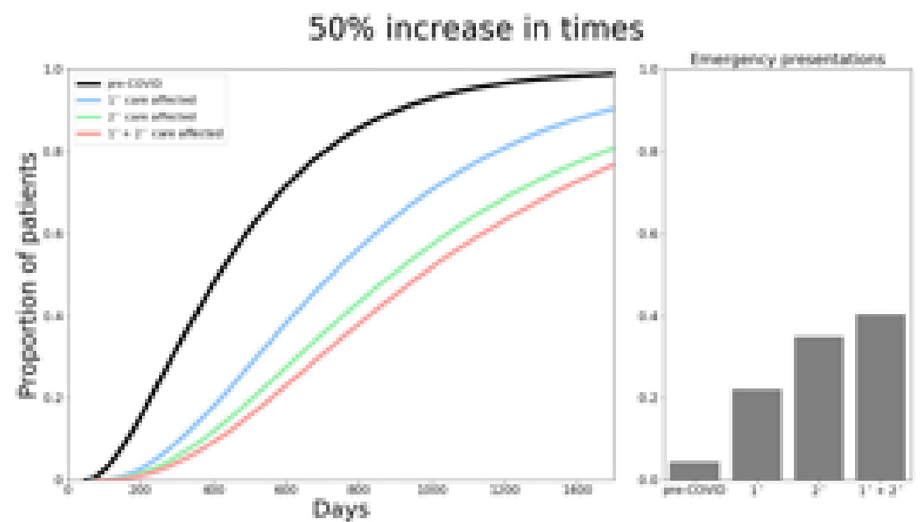
Fig 3. Total time from symptom onset to diagnosis and proportion of emergency presentations if primary, secondary and both care services are increased by